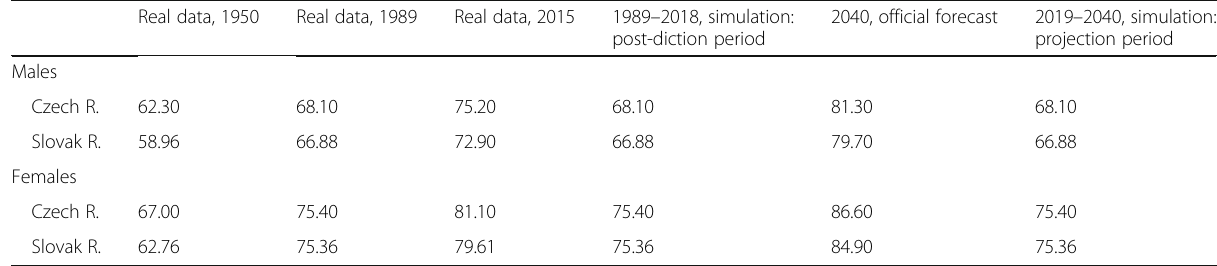
Table 2 Overview of values of life expectancy in selected years Real data,